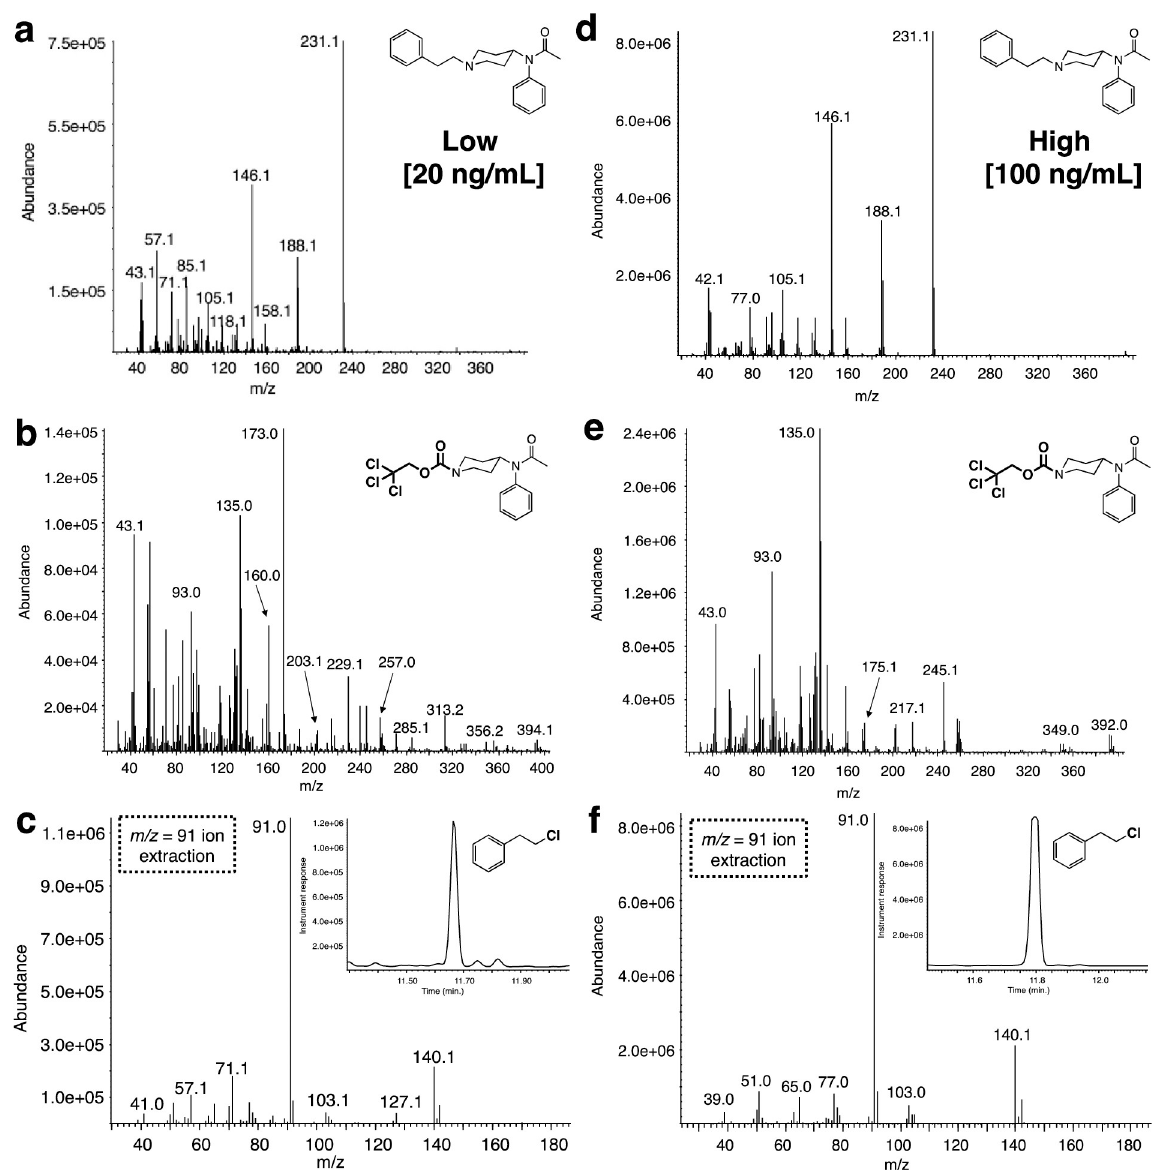
Fig 10. Mass spectral data associated with the reaction between acetylfentanyl-spiked urine matrices with Troc-Cl. Mass spectra for (a) extracted fentanyl when spiked at 20 ng/mL; (b) Troc-norfentanyl product arising from the treatment of fentanyl-spiked urine extract (20 ng/ mL) with Troc-Cl; (c) and 2-phenylethyl chloride, the second confirmatory by-product from the reaction; mass spectra for (d) extracted fentanyl when spiked at 100 ng/mL; (e) Troc-norfentanyl product arising from the treatment of fentanyl-spiked plasma extract (100 ng/mL) with Troc-Cl; (f) and 2-phenylethyl chloride for the highest concentration